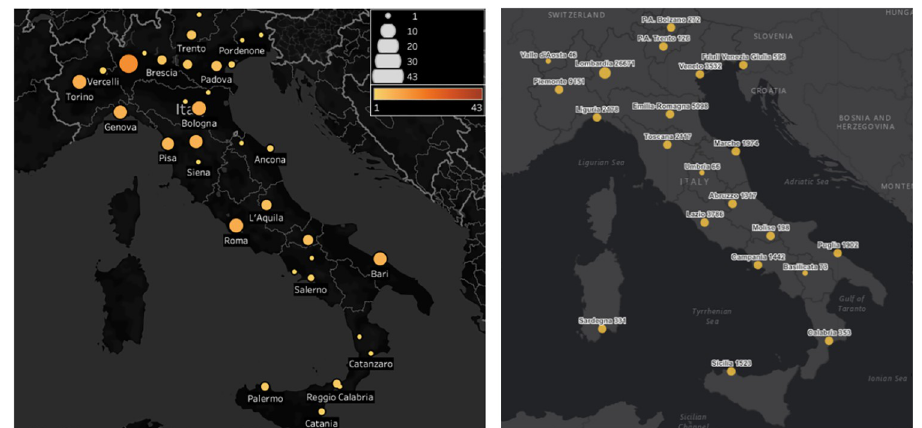
Fig 5. Comparison between the number of IT initiatives (a) and the number of SARS-Cov-2 cases in Italy on May 2020 [54] (b).